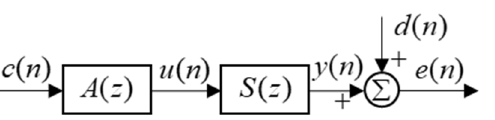
Figure 3. Simply expressed block diagram of the ASE algorithm.